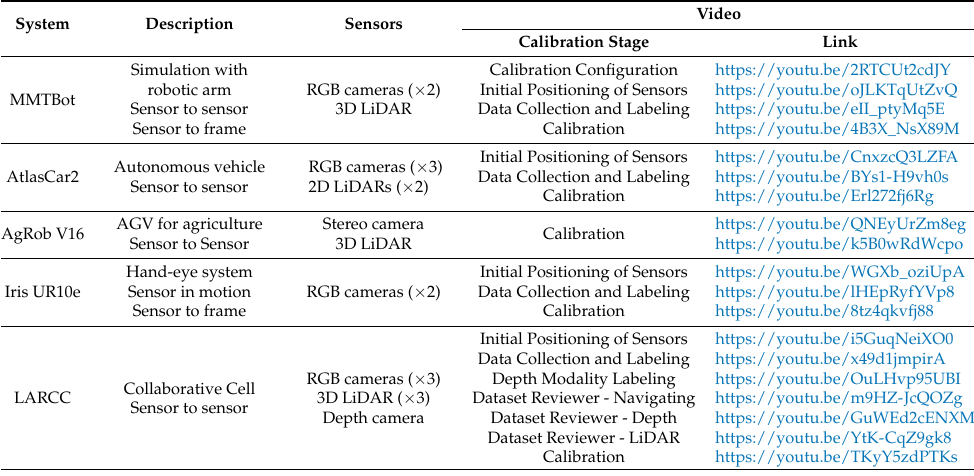
Table 1. ATOM calibrated systems with demonstrative videos. All videos accessed in 25 Novem- ber